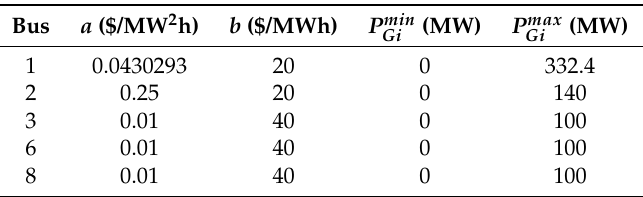
Table 1. Generator parameters in IEEE 14-bus